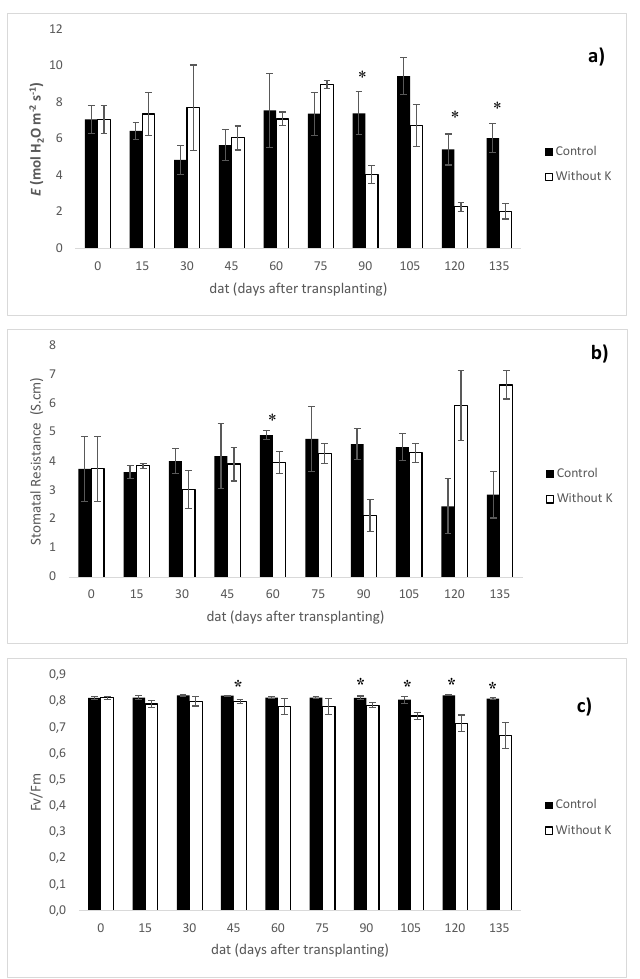
Fig. 2: Physiological parameters in the tree tomato plants during vegetative growth. Treatments: Control (without deficiency) and plants grown without K (potassium deficiency). a) Transpiration rate ( E ), b) Sto- matal resistance ( SR ); and c) Maximum photochemical efficiency of photosystem II ( Fv/Fm ). Bars represent the standard error (n = 4 plants per treatment). Significant differences at the 0.05 level of significance are indicated by * (the Tukey’s test).